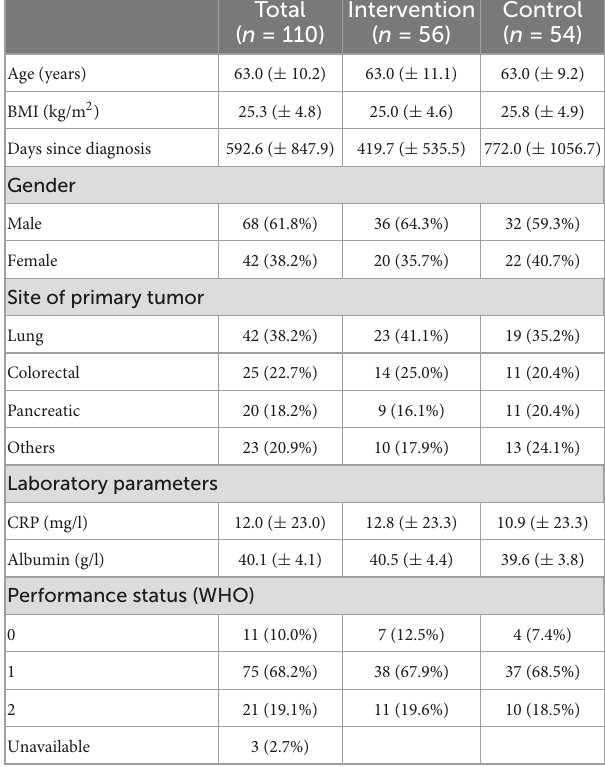
TABLE 1 Baseline characteristics of study patients, given are means ± standard deviation, or number with proportion in percent,